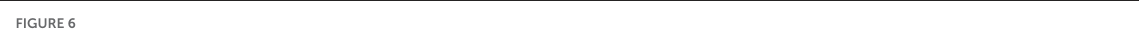
FIGURE6 composition at the genus level. (G,H) The relative abundance of Desulfovibrio was significantly decreased and that of Bacteroides was significantly increased after ezetimibe intervention by Metastas analysis. * p < 0.05. LCBD, Local contributions to beta-diversity, LCBD values represent the degree of uniqueness of the sampling units in terms of community composition. NCD, normal diet; HFD, high-fat diet; HFD + ORL, high-fat diet and intervention of orlistat; n = 6 per group.